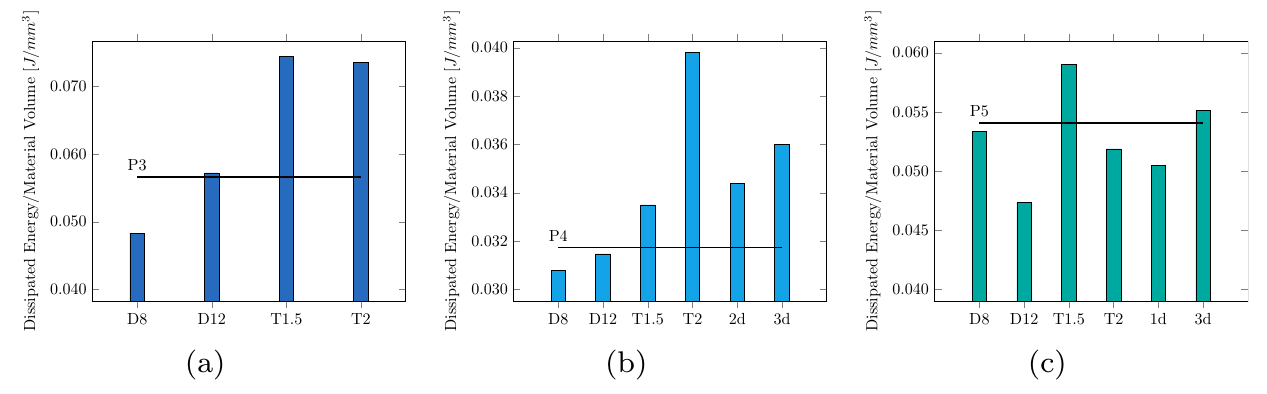
Figure 15. Coefficient between total dissipated energy and material volume of the dissipating plate for P3 ( a ), P4 ( b ) and P5 ( c ) when depth, thickness, and the number of diagonals vary. The black line represents the coefficient of the original damper